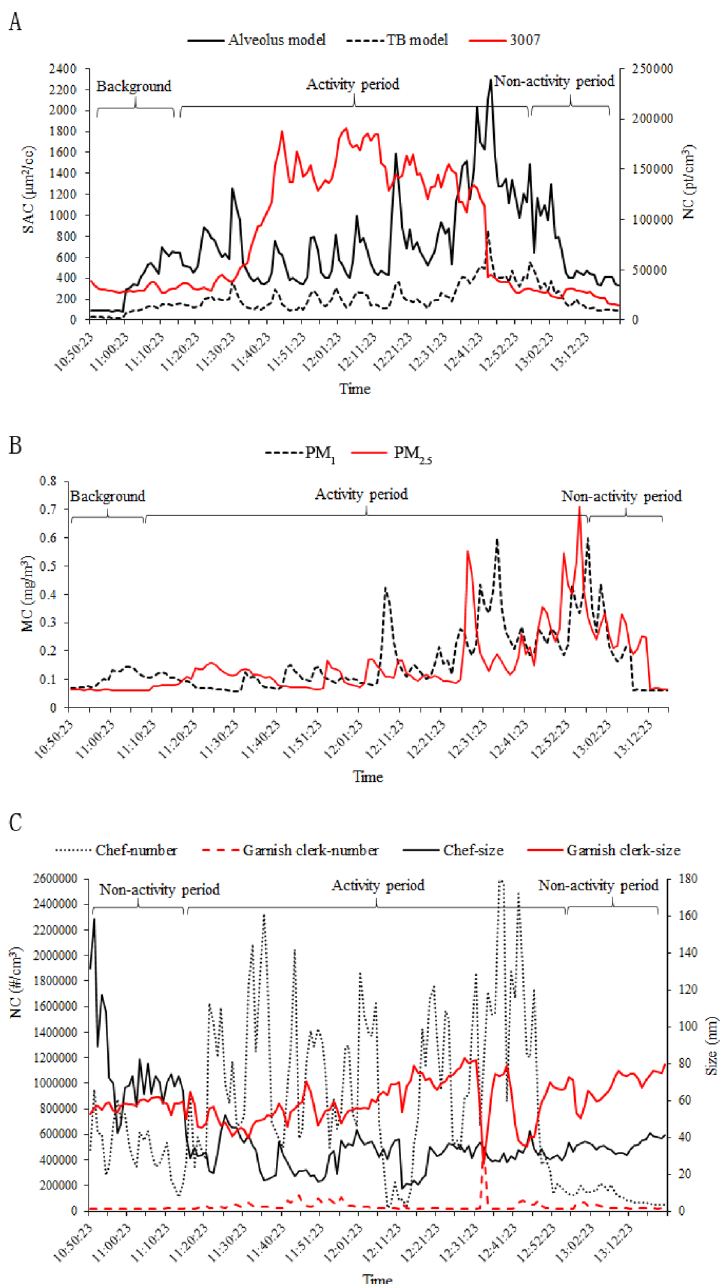
Figure 2. Temporal variations in total particle concentrations associated with working activities. ( A ) Temporal variations in total surface area concentration (SAC) and number concentrations (NC) at background and operation locations. ( B ) Temporal variations in total respirable mass concentration (MC) at the background and operation locations. ( C ) Temporal variations in personal NC and its size during the working and non-activity